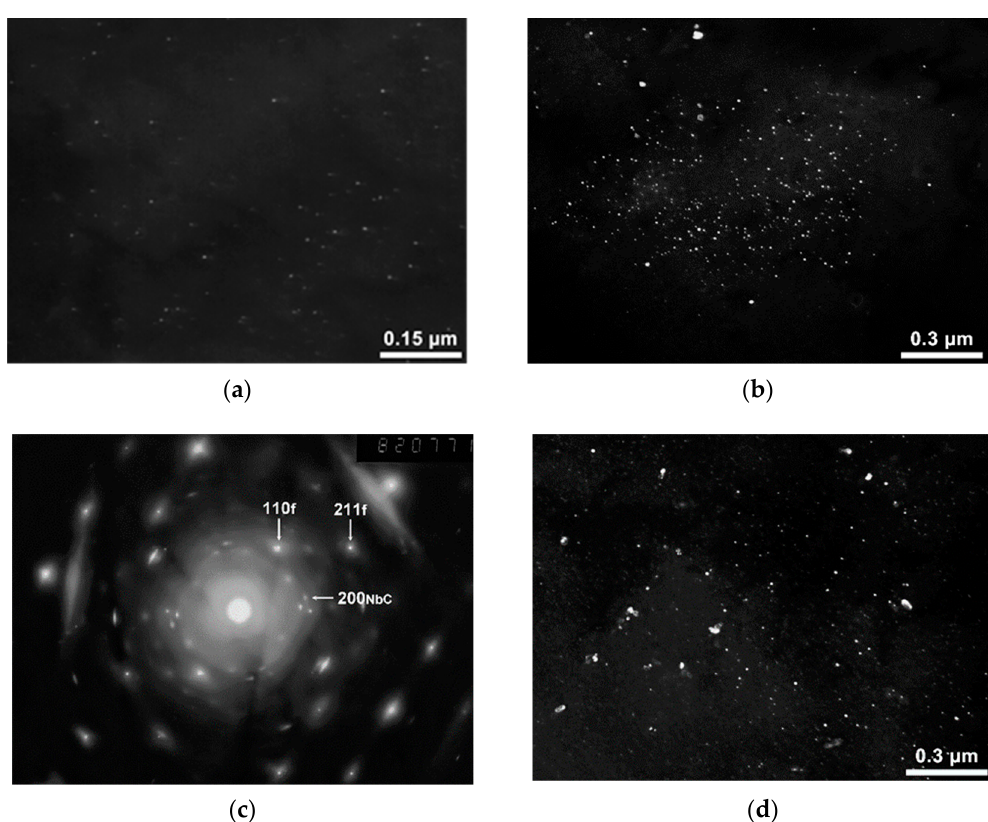
Figure 7. Nanosized NbC particles in samples of the batches (TEM): ( a ) No. 1-1; ( b ) No. 2-2; ( c ) No. 2-2; ( d ) No. 2-1. Dark-field images in reflections of nanocarbides ( a , b , d ) and microdiffraction pattern with marked reflections of NbC and (some) ferrite—f ( c ).